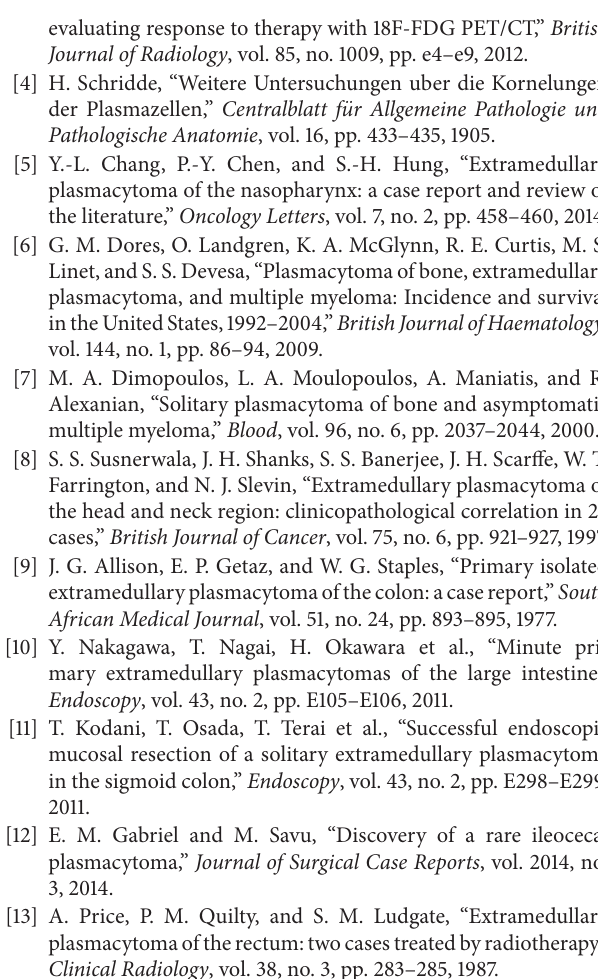
to MM varies from 10% to 30% in P-extramedullary.